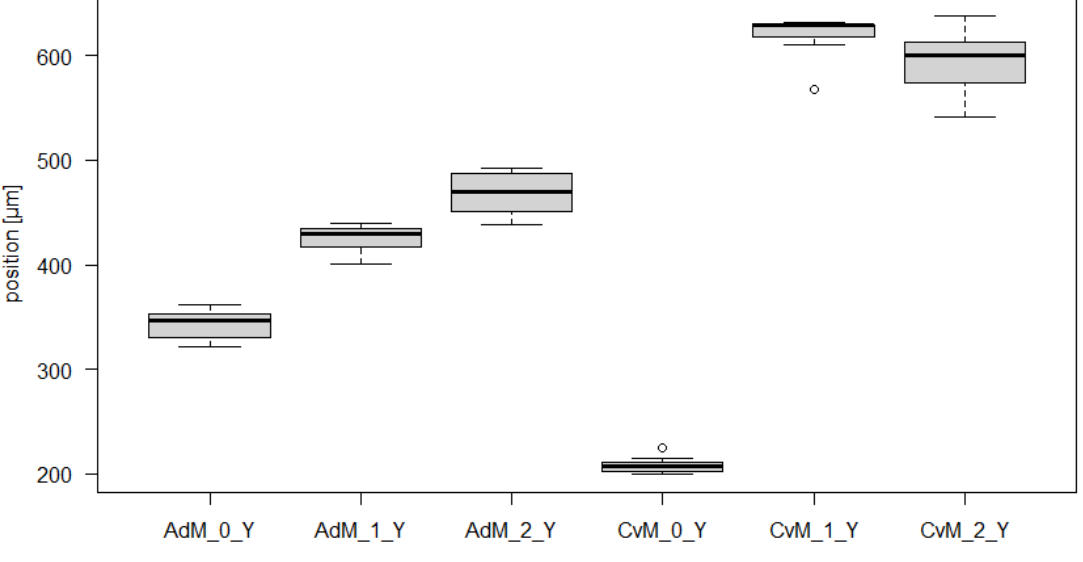
Figure 17. Measurements of NcM axis Y.